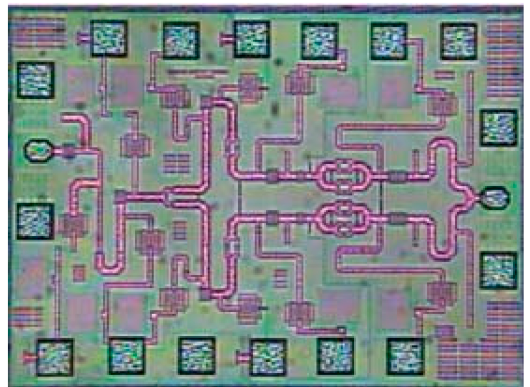
Figure 6. Chip photo of the D-band eight-way combining common-source power amplifier (CS PA)